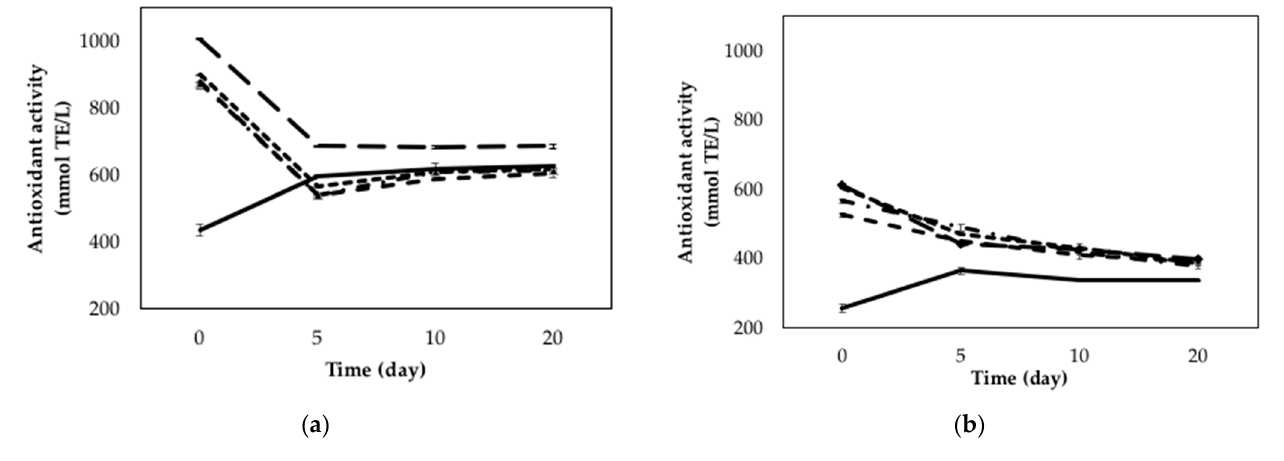
Figure 3. Effect of UV-C irradiation and thermal treatment (HTST or UHT) on antioxidant activity (mmol TE/L) in red prickly pear juice: ( a ) juice at pH 3.6 ( b ) juice at pH 7. — Thermal treatment — —Juice untreated; – – UV-C (31.87 mJ/cm 2 ), – · – UV-C (15.13 mJ/cm 2 ), --- UV-C (9.81 mJ/cm 2 ). Whit respect to pigments, betacyanin content in untreated juices was 16.65 and 15.66 mg/L at pH 3.6 (Figure 4a) and 7 (Figure 4b), respectively. UV-C treatment at day zero